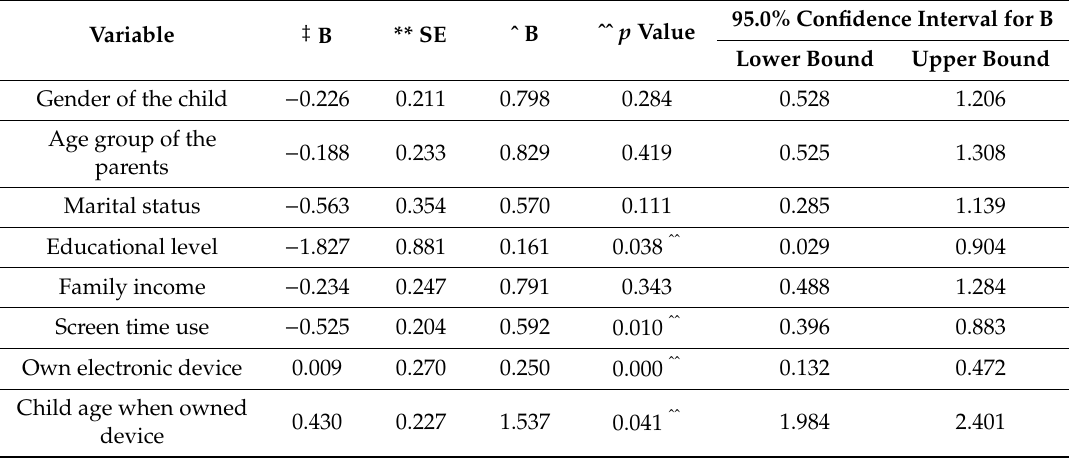
Table 3. Predictors of low level physical activity level among children of sampled